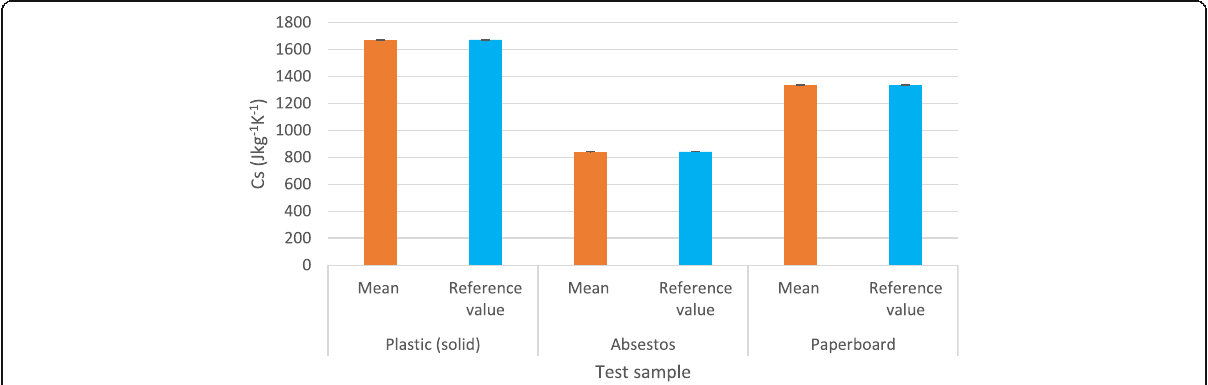
Fig. 3 Chart showing day 1 reference and mean measured specific heat capacity values of the test